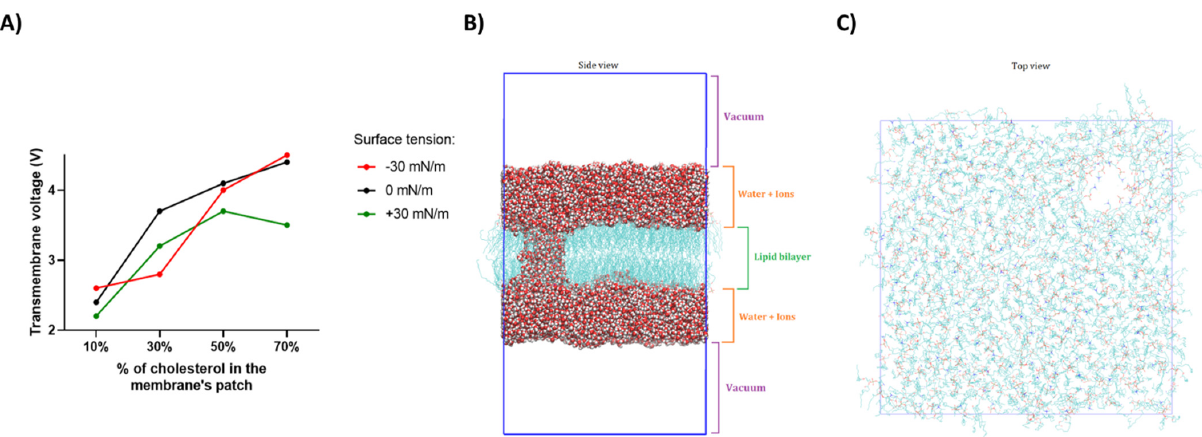
Figure 4. Membrane’s patch electroporation threshold after application of µ sPEF with respect to the cholesterol content- molecular dynamics studies. ( A ) The graph shows the minimal ionic imbalance across the simulated membrane, which is needed to form a pore in the membrane; ( B ) shows the electropore throughout the membrane induced by the ionic imbalance in the system composed of two water slabs separated by the membrane and vacuum; ( C ) shows the top view of the electropore in the membrane.